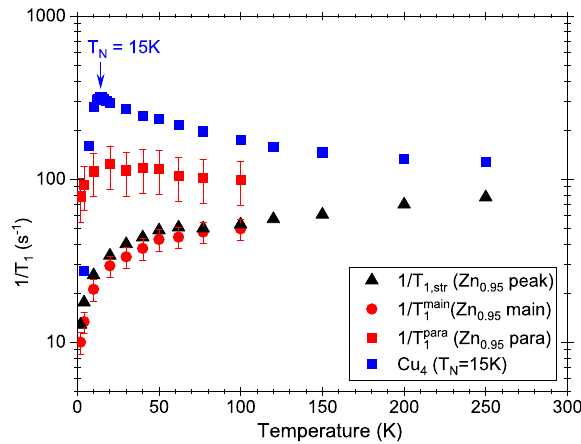
Fig. 8 Temperature dependences of 1/ T 1 . The central value 1 = T main 1 ( ) of the main peak and 1 = T para ( ) of the paramagnetic peak 1 observed for Zn 0.95 , as estimated from the peak of the double Gaussian fi t of C ( f ; 1/ T 1 ). The vertical error bars specify the maximum possible range of uncertainties. For comparison, we also show 1 = T 1 ; str observed at the nominal peak frequency 19 f peak of Zn 0.95 ( ▴ , same stretched fi t results as in Fig. 4a) and Cu 4 (